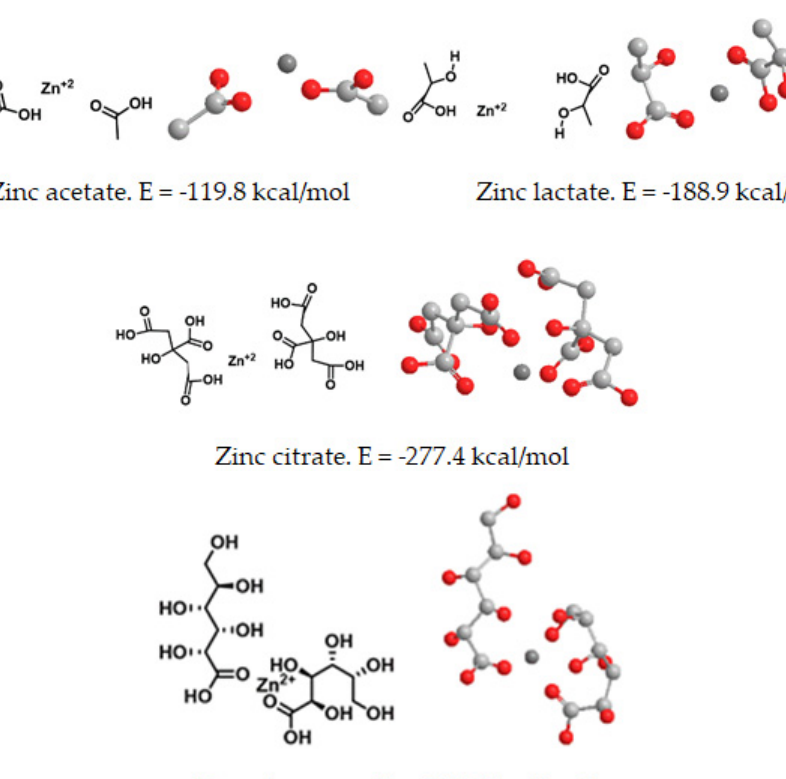
Figure 6. Energy and most favorable spatial orientation of zinc acetate, zinc lactate, zinc citrate and zinc gluconate. Light grey balls represent carbon atoms. Red balls represent oxygen atoms. Non-linked dark grey balls represent zinc cations. Table 2. Molecular mechanics computed energy E of free forms of zinc salts of organic acids and when forming complexes with the amino acid tryptophan and the flavonoid silybin.